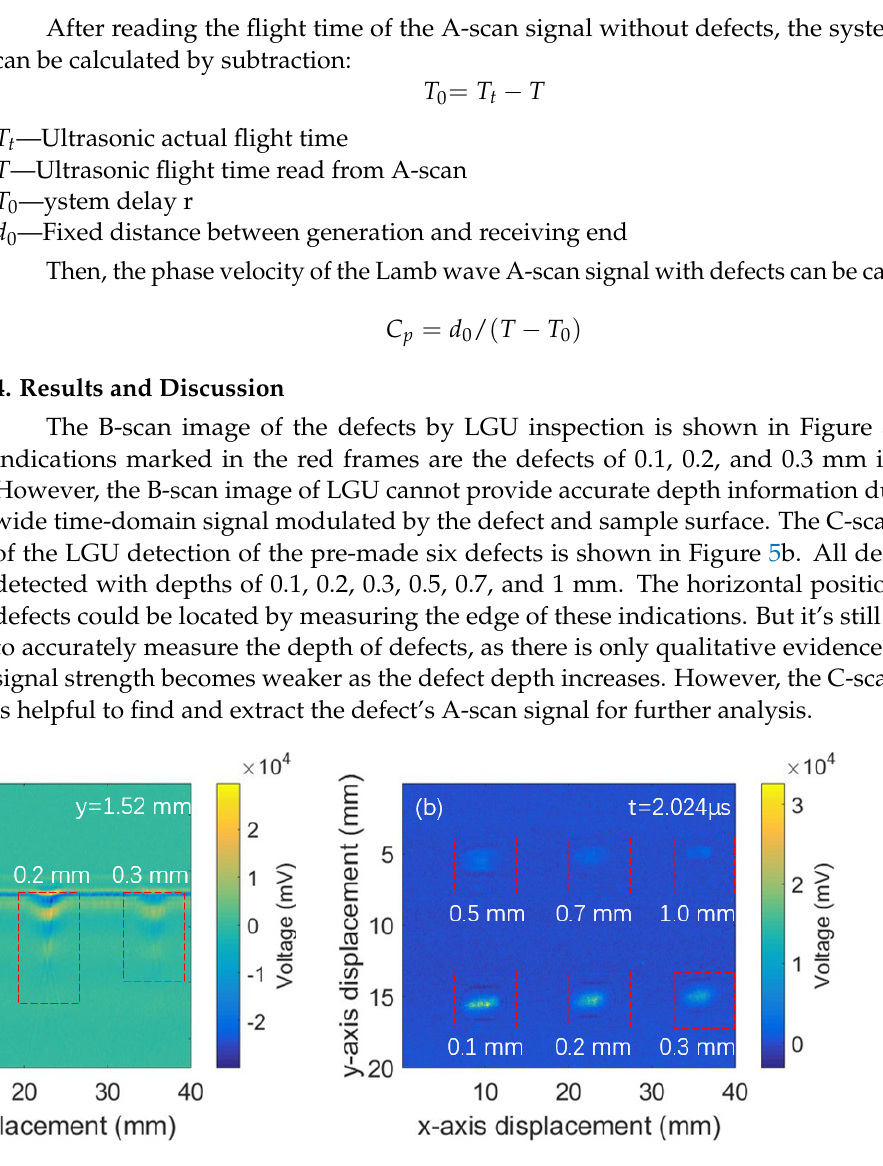
Figure 5. ( a ) B − scan and ( b ) C − scan plots of LGU inspection of